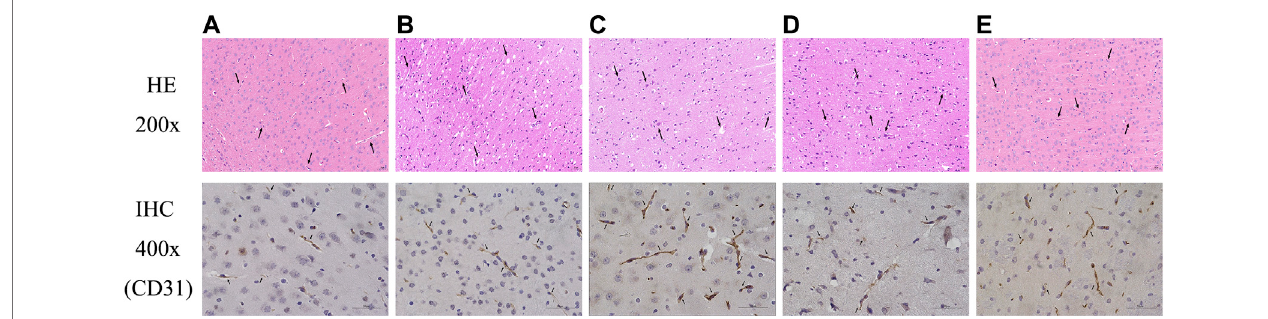
FIGURE5| FYXNimprovedmorphologyandpromotedangiogenesisinDMCIrats.RepresentativeimagesofHEandimmunohistochemistryareshownasfollows: (A) DM sham group, (B) DMCI group, (C) FYXN group, (D) Nim & Met group and (E) NC group.